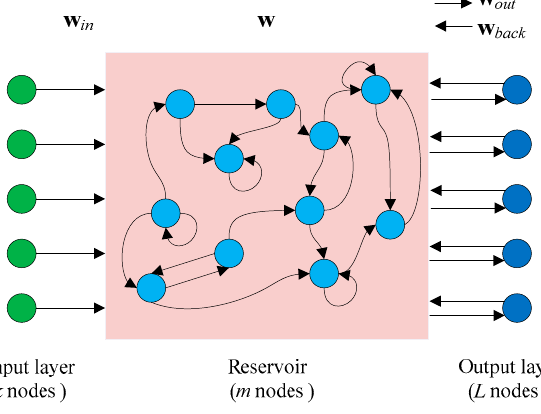
Figure 1. Schematic of the ESN (Echo State Network).